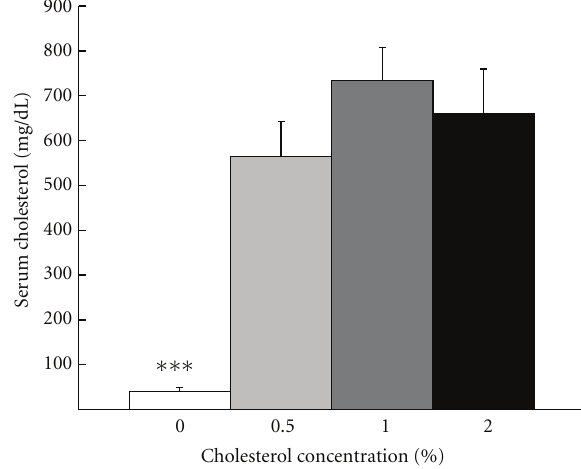
Figure 2: Mean total serum cholesterol levels at euthanasia for rabbits in the 0%, 0.5%, 1%, and 2% cholesterol groups. ∗∗∗ P < .